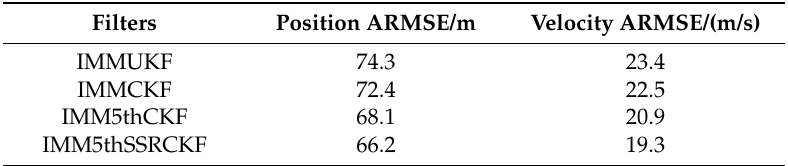
Table 1. Comparisons of accumulative RMSE (ARMSE) among the four algorithms. Filters Position